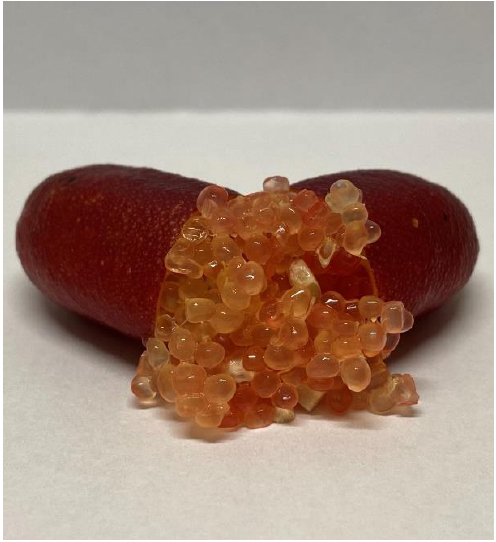
Figure 1. ‘Red Champion’ finger lime (photo credit: Oliver Cohen).